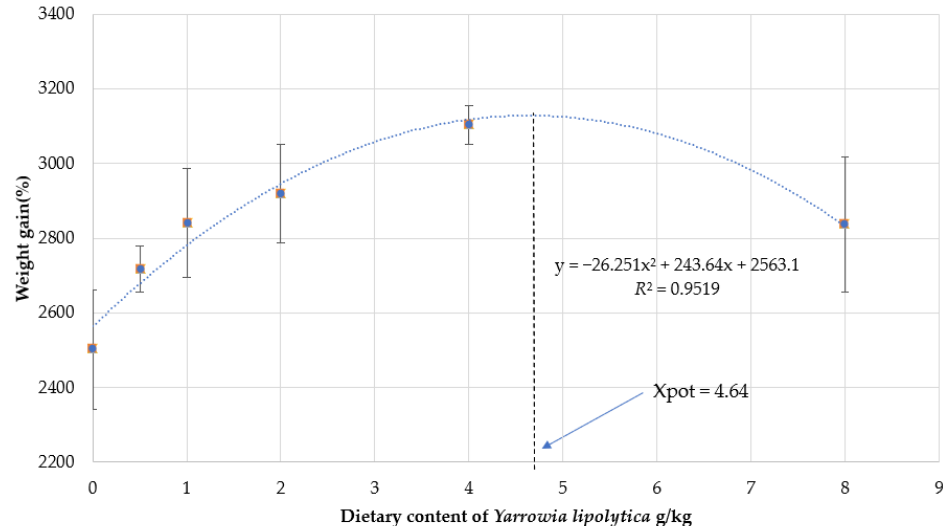
Figure 1. The relationship between the weight gain rate of shrimp and the content of Yarrowia lipolytica in feed based on quadratic regression analysis.